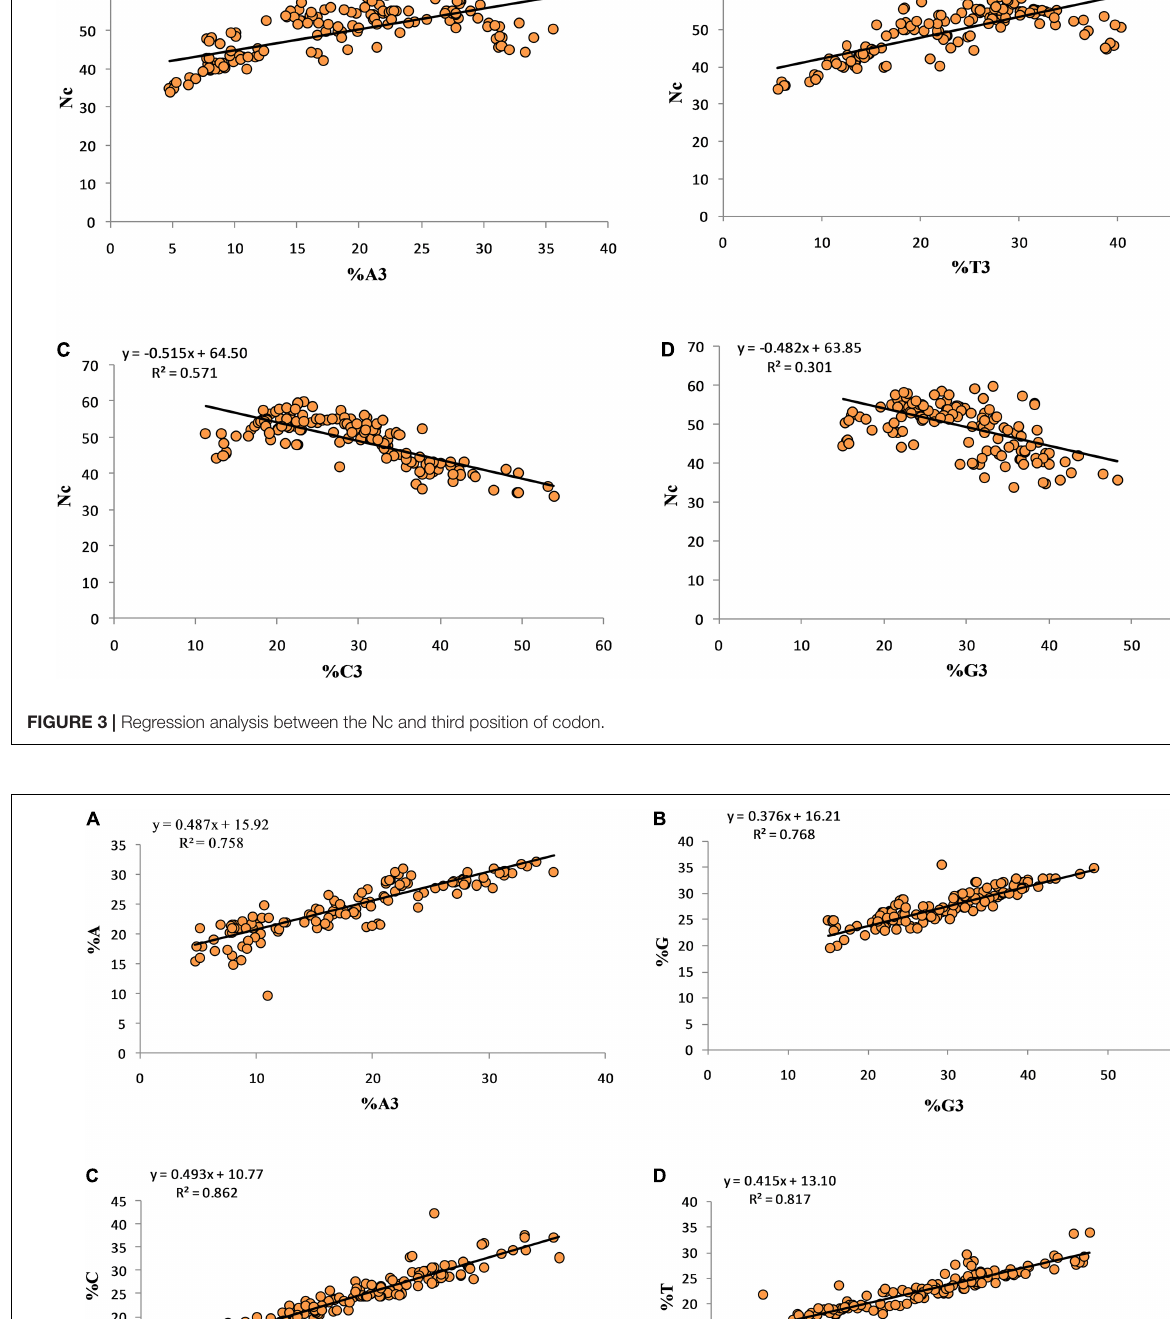
Frontiers in Neuroscience |